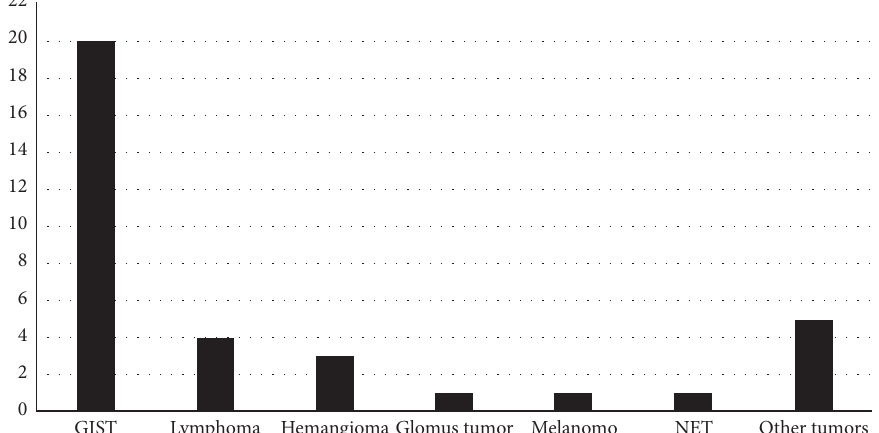
Figure 1: Tumor types based on the histological diagnosis. Abbreviation: GIST, gastrointestinal stromal tumor; NET, neuroendocrine tumor. Values are the number of